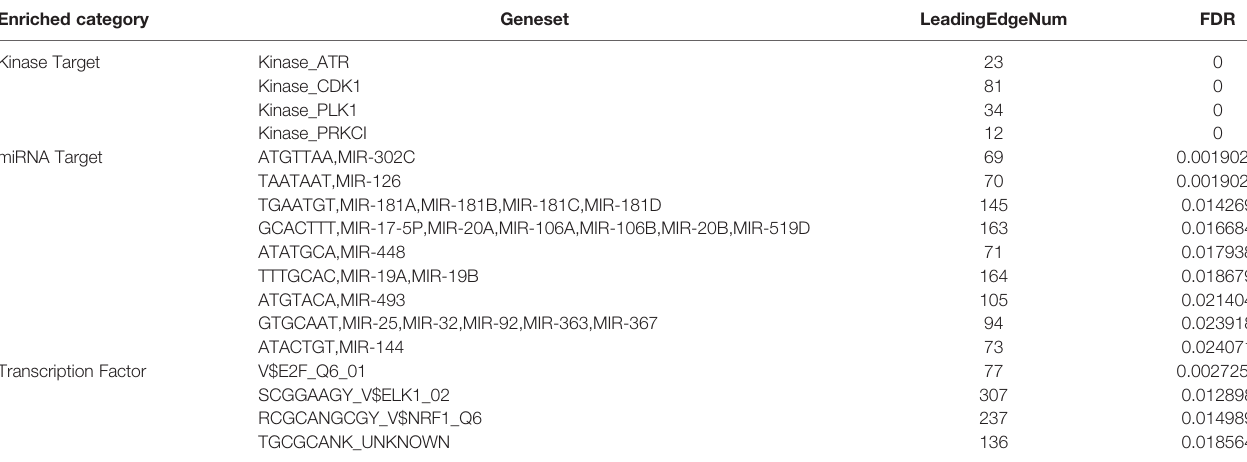
TABLE 3 | The Kinase, miRNA and transcription factor-target networks of PAFAH1B3 in HCC (LinkedOmics). Enriched